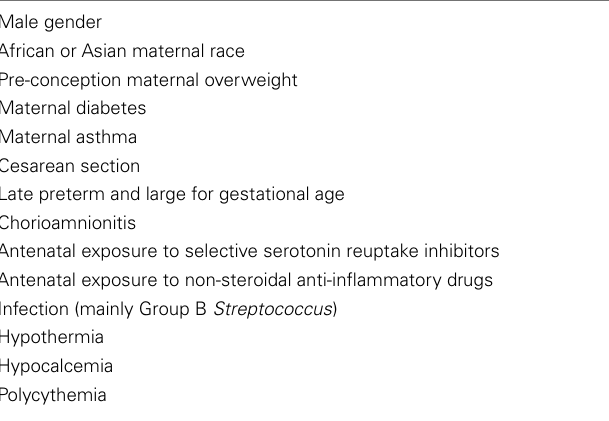
Table 1 | Potential risk factors for the development of